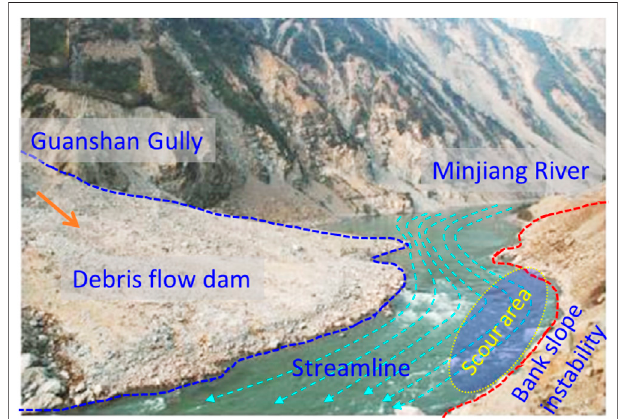
FIGURE 3 | Partial blockage pattern of debris fl ow causes serious scouring on the opposite bank (In 2008, a debris fl ow occurred in Guanshan gully, Sichuan province, China, partially blocking the Minjiang River. After the sharpde fl ectionoftheriver fl owstreamline,thebankslopewasscoured, resulting in the instability and failure of the opposite bank